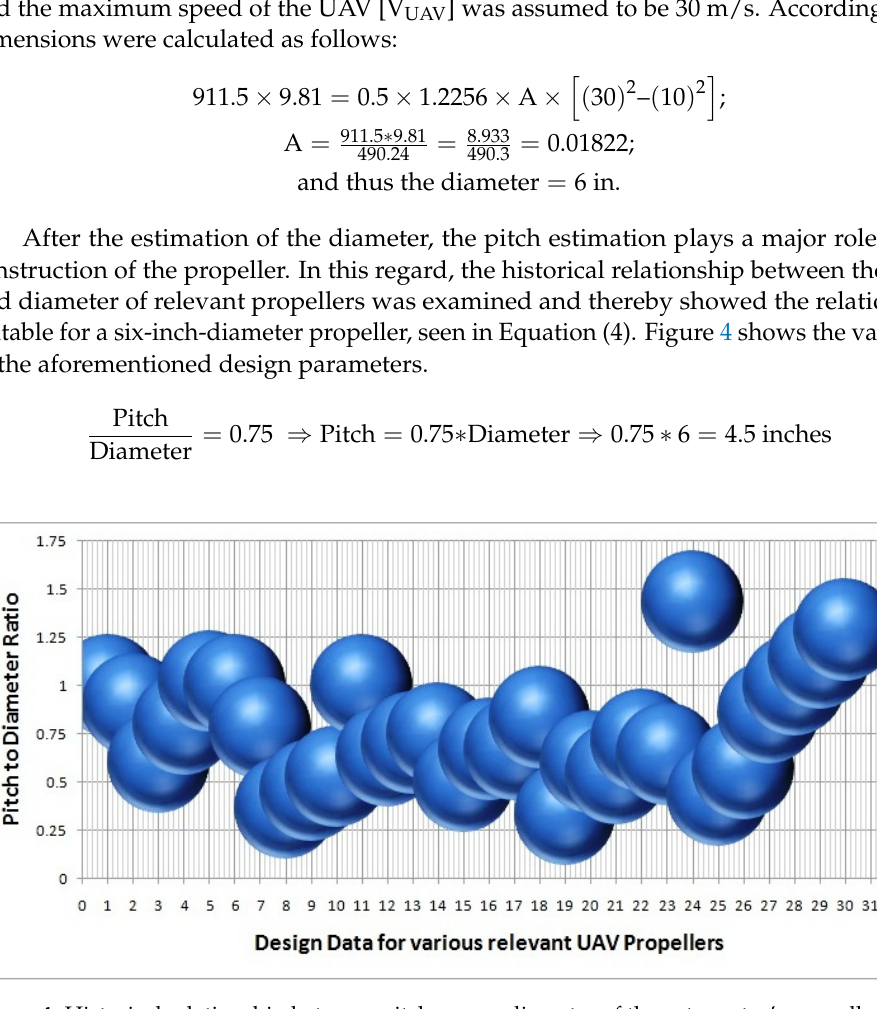
Figure 4. Historical relationship between pitch versus diameter of the octocopter’s propellers